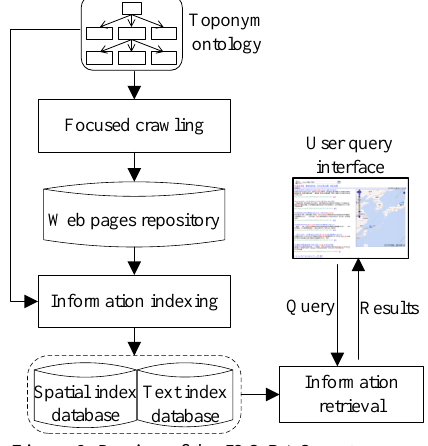
Figure 3. Design of the IGS-BAS